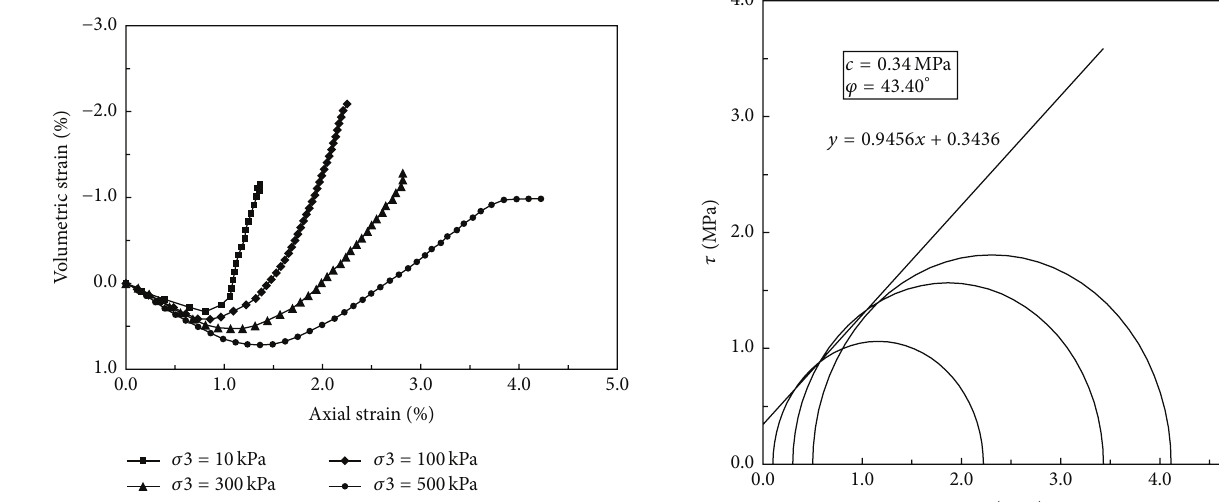
Figure 2: Deviatoric stress-axial strain curves of simulated soft rock specimen.